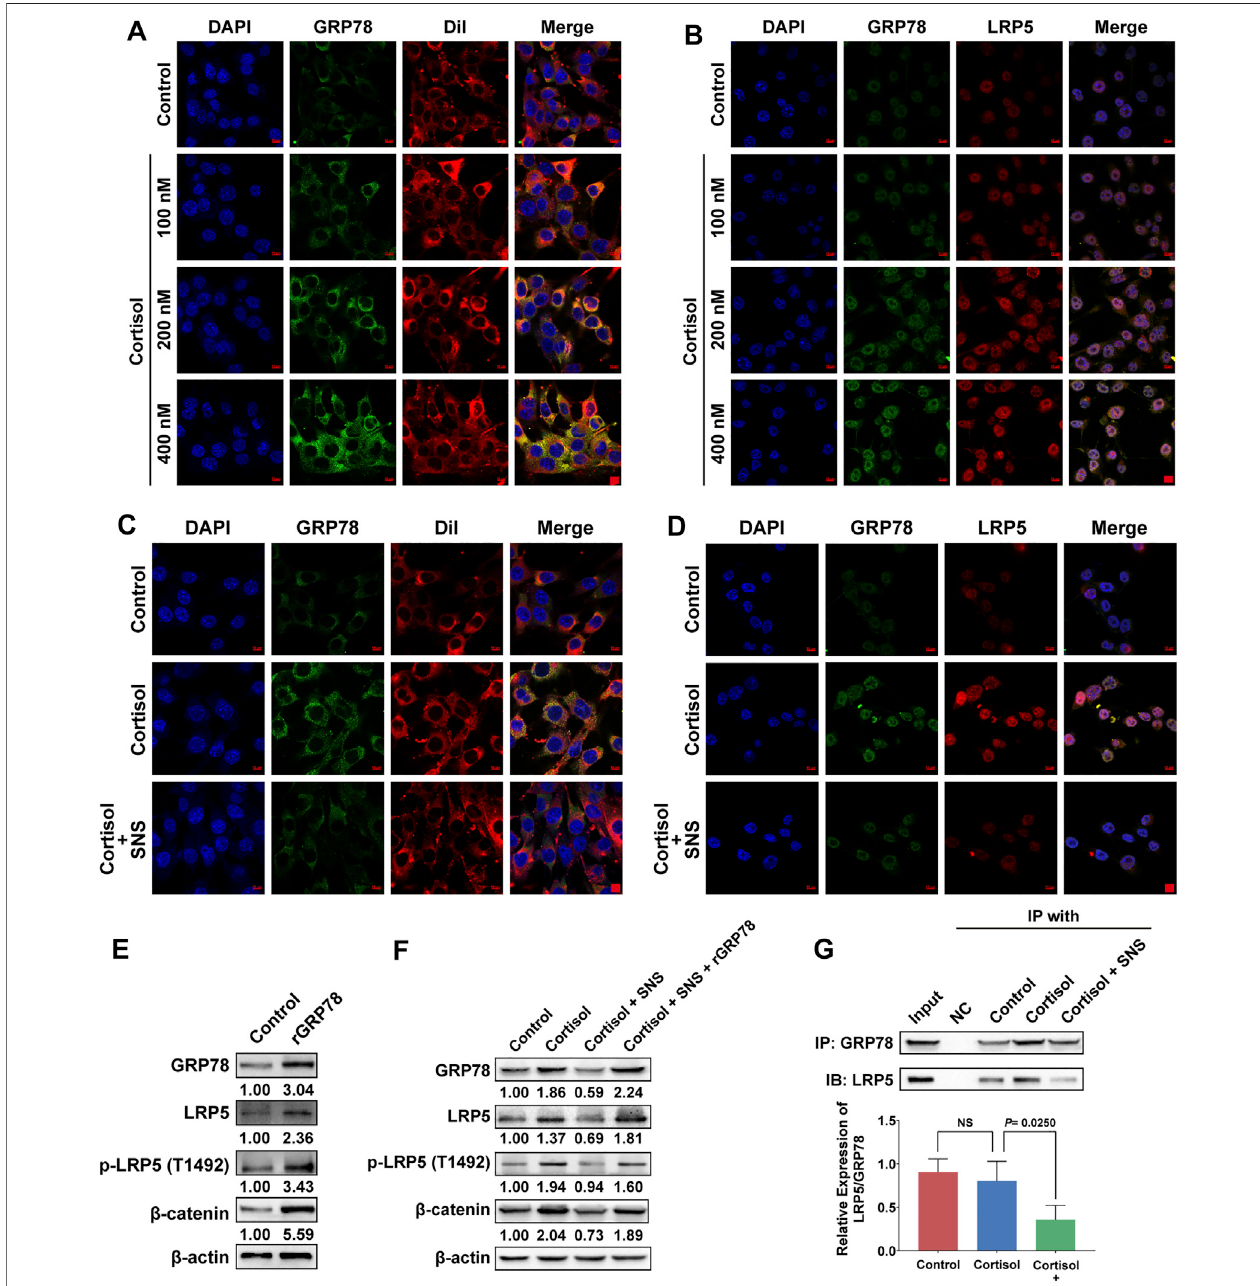
FIGURE 6 | SNS interrupts the interaction between GRP78 and LRP5 to suppress Wnt/ β -catenin signaling. (A) After 4T1 cells were treated with cortisol for 24 h, thetranslocationofGRP78tothecellmembranewasmonitoredbyimmuno fl uorescence.Red:DiI-cellmembranetracker;green:GRP78.Co-localizationofGRP78and the cell membrane is shown as yellow fl uorescence. (B) The 4T1 cells were treated with cortisol for 24 h, and the co-localization of GRP78 and LRP5 was detected by immuno fl uorescence. Co-localization is shown as yellow fl uorescence. (C) The effect of SNS (200 μ g/ml) on cortisol-induced cell membrane translocation of GRP78wasdetectedbyimmuno fl uorescencefollowingSNStreatmentfor24 h. (D) TheeffectofSNS(200 μ g/ml)ontheco-localizationofGRP78andLRP5inducedby cortisolwas detected by immuno fl uorescence following SNS treatment for 24 h. (E) The expression of LRP5, p -LRP5, and β -catenin in the GRP78-overexpressing 4T1 cells was measured by western blots. (F) The 4T1 cells or GRP78-overexpressing 4T1 cells were treated with SNS (200 μ g/ml) for 24 h, and the changes in cortisol- induced LRP5, p -LRP5, and β -catenin expression were detected by western blots. (G) The 4T1 cells were treated with SNS (200 μ g/ml) for 24 h, and changes in the interaction of GRP78 with LRP5 were analyzed by Co-IP assays. Input represents the total protein extracts prepared without the antibody coupling resin. NC indicates the negative control prepared by adding quenching buffer to the antibody coupling resin. NS, not signi fi cant. The scale bars indicate 10 μ m. One representative experiment of three independent experiments is